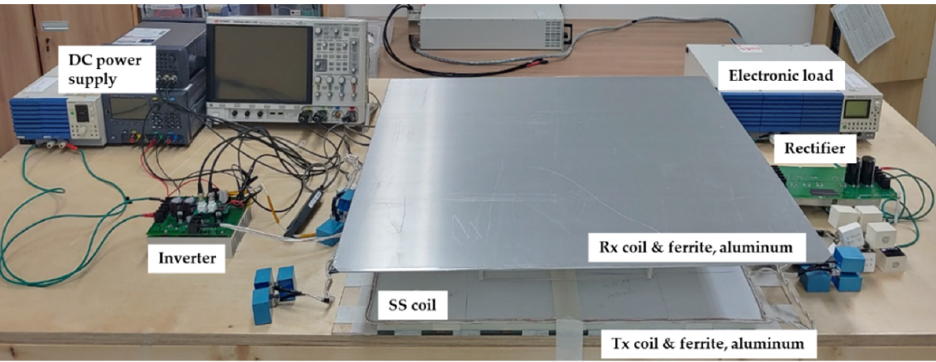
Figure 16. Experimental setup for the measurement using the SAE J2954 model.